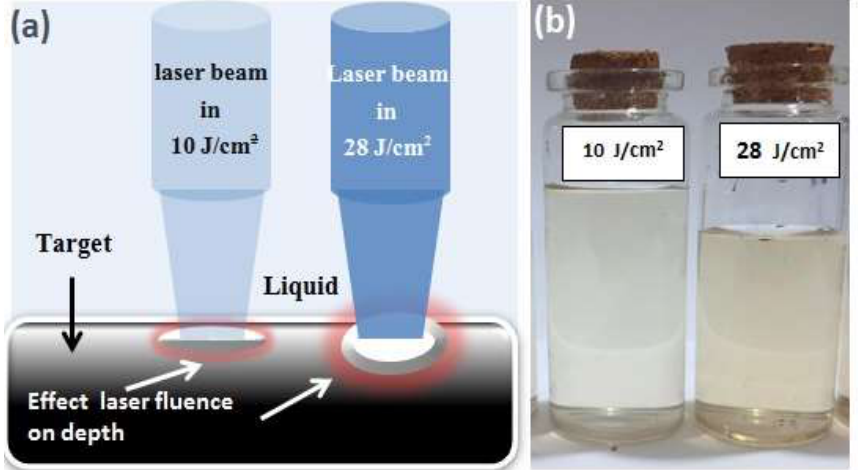
Figure 7: The laser ablation of Fe plate in liquid at (a) difference laser fluence, and (b) coloration of the suspensions prepared with different fluences (10 & 28) J /cm